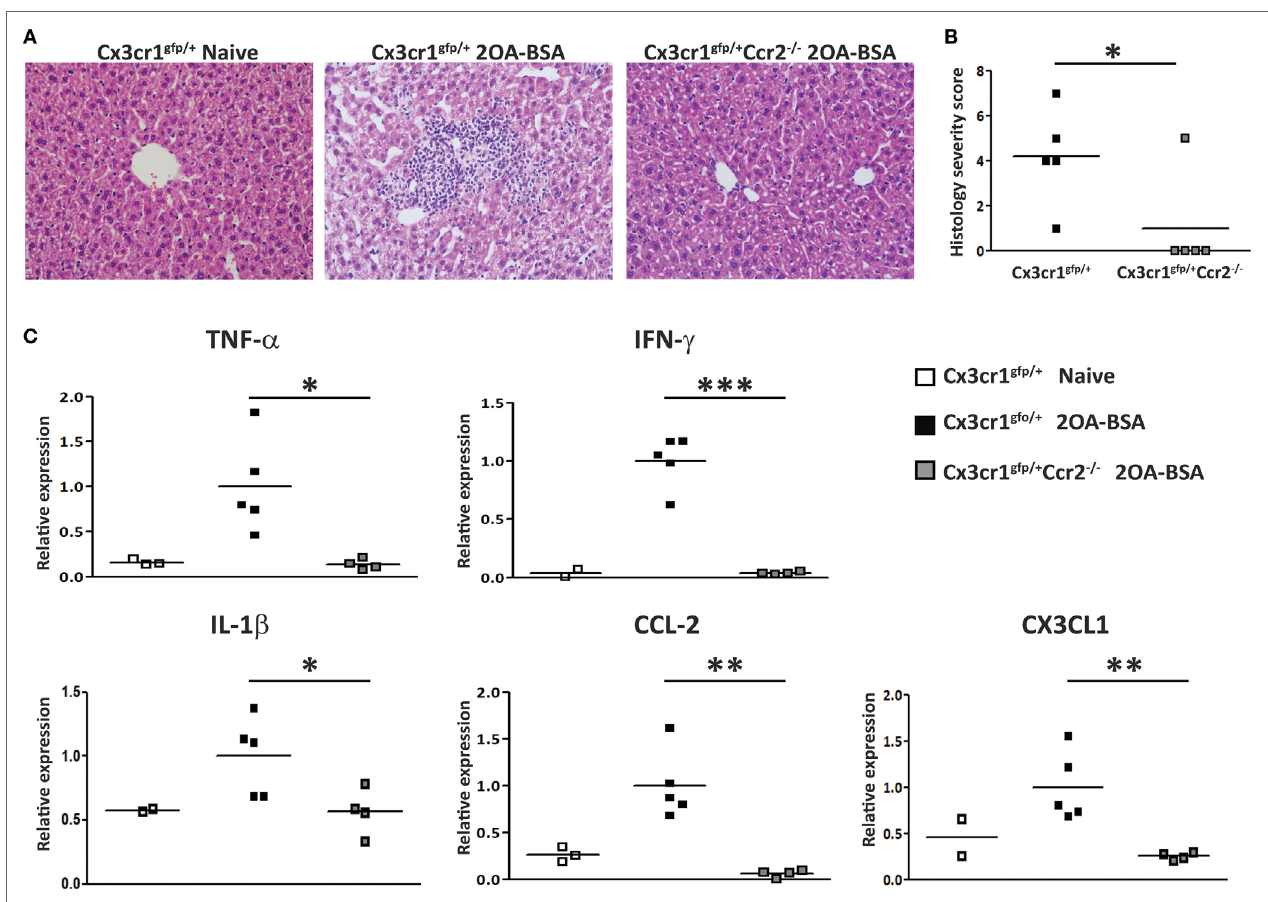
FigUre 2 | C-C motif chemokine receptor 2-deficient mice display attenuated disease severity in the 2-octynoic acid conjugated to bovine serum albumin (2OA-BSA) autoimmune cholangitis model. (a) Representative liver histology (hematoxylin and eosin staining) of indicated mice, original magnification 40 × . (B) Graphical summary of histological disease severity score. (c) Graphical summary of hepatic cytokines expression levels of indicated mice. All data are presented as mean, n ≥ 5 per experimental group. Results are representative of three or more independent experiments. * p < 0.05 and ** p < 0.01 (unpaired Student’s t